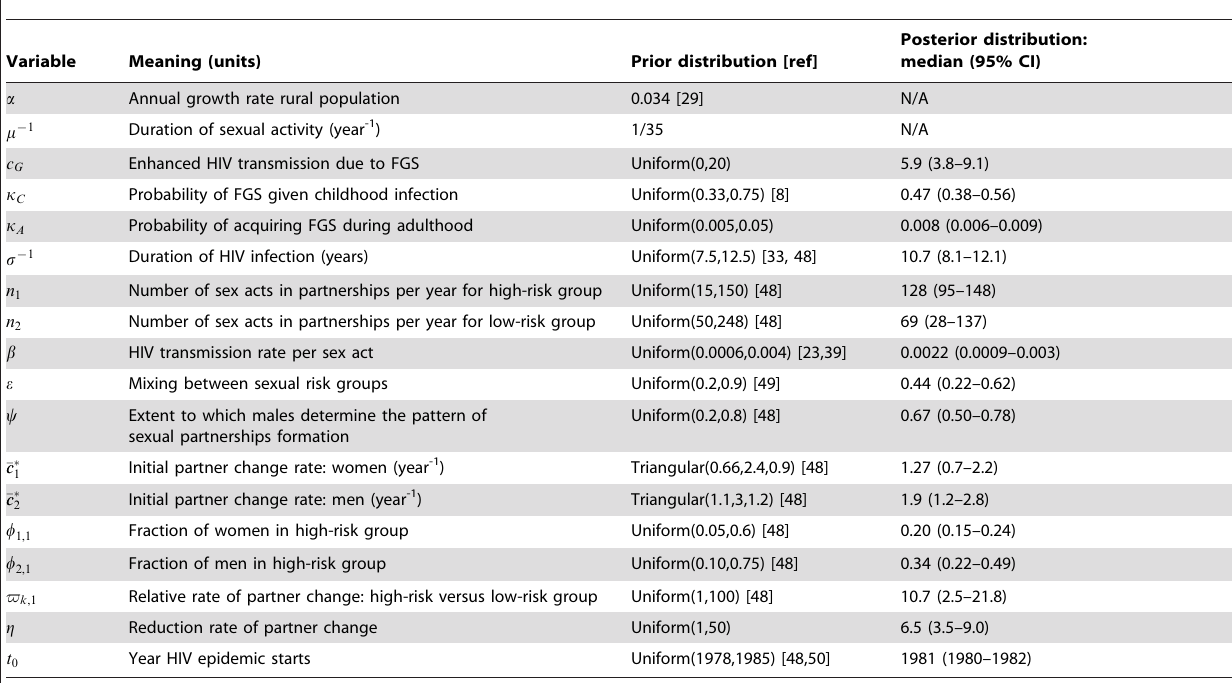
Table 1. Estimates of the parameters used in our dynamic HIV-FGS model (Figure 1).